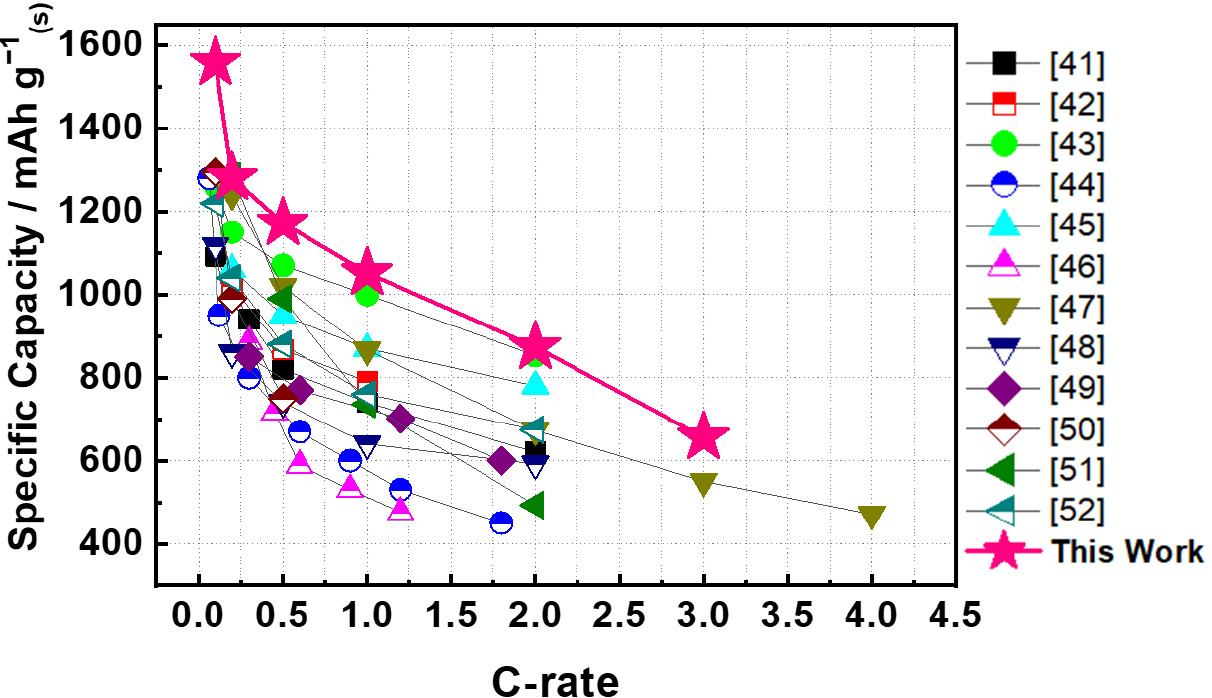
Figure 8. Comparison of the rate capabilities of lithium-sulfur batteries incorporating different types of interlayer or functional separators [41 – 52].